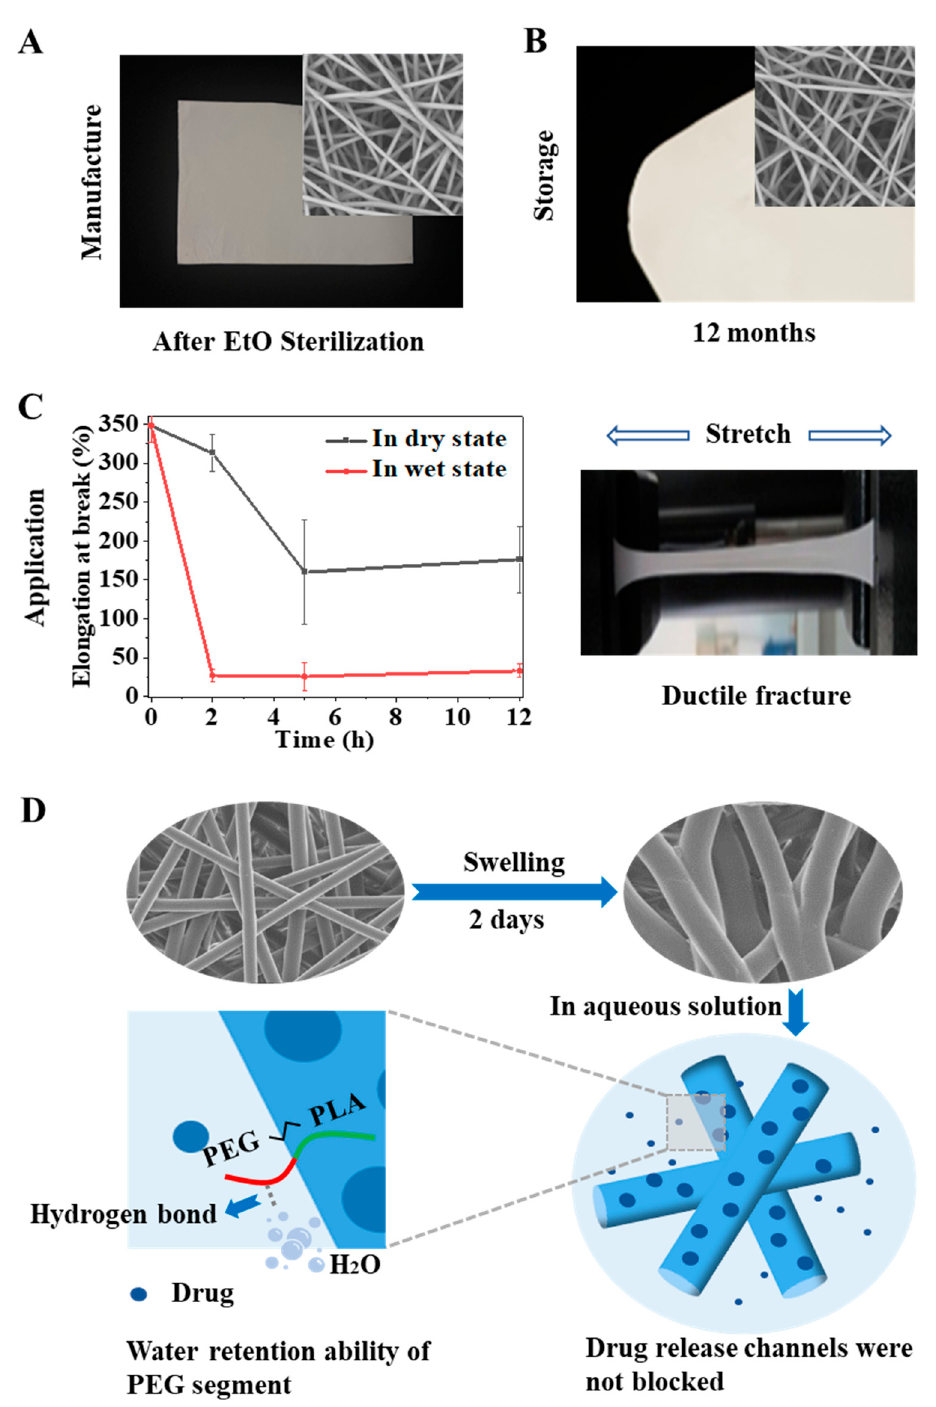
Figure 6. Stability improvement of the PLGA/PELA 85/15 membrane. Improvement in the morphol- ogy and performance of the PLGA/PELA 85/15 electrospun membranes during manufacture ( A ); storage ( B ); application ( C ). ( D ) Schematic illustration of the drug-release behavior of the 85/15 membrane in aqueous solution.